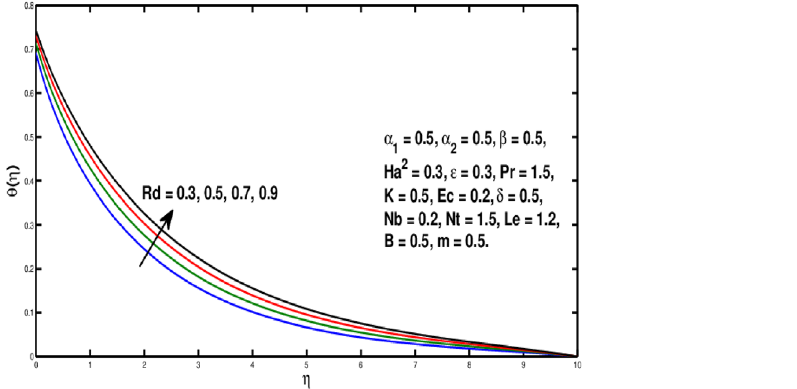
Figure 7. Variation of Rd on θ(η)